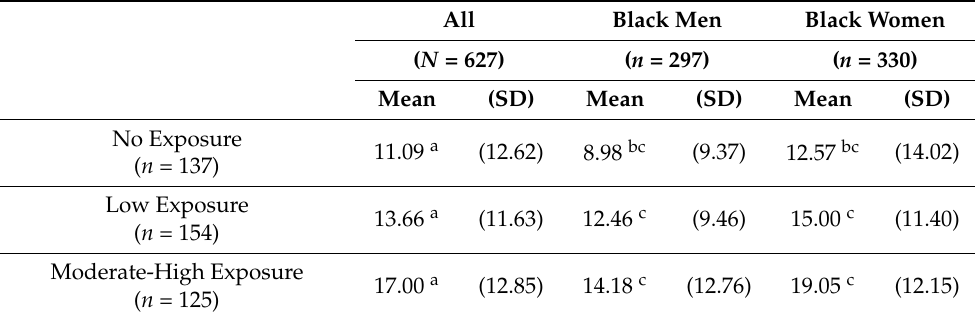
foNote: This table examines the association between depressive symptoms and major discrimination among Black Americans by comparing mean depressive symptoms scores across levels of discrimination exposure (i.e., no, low, vs. moderate-high exposure). The superscripts “a”, “b”, and “c” indicate statistically significant ( p < 0.05) differences in depressive symptoms, allowing for multiple contrasts within the full sample and separately among Black men and women. First, superscript (a) indicates that among the full sample (i.e., within the “All” column), there are significant differences in depressive symptoms across levels of discrimination exposure. Second, superscript (b) denotes significant gender differences in depressive symptoms scores within each level of discrimination exposure. In other words, it notes whether men and women with similar levels of discrimination exposure (i.e., no, low, vs. moderate-high exposure) have significantly different depressive symptoms scores. Finally, superscript (c) shows whether there are statistically significant differences in depressive symptoms